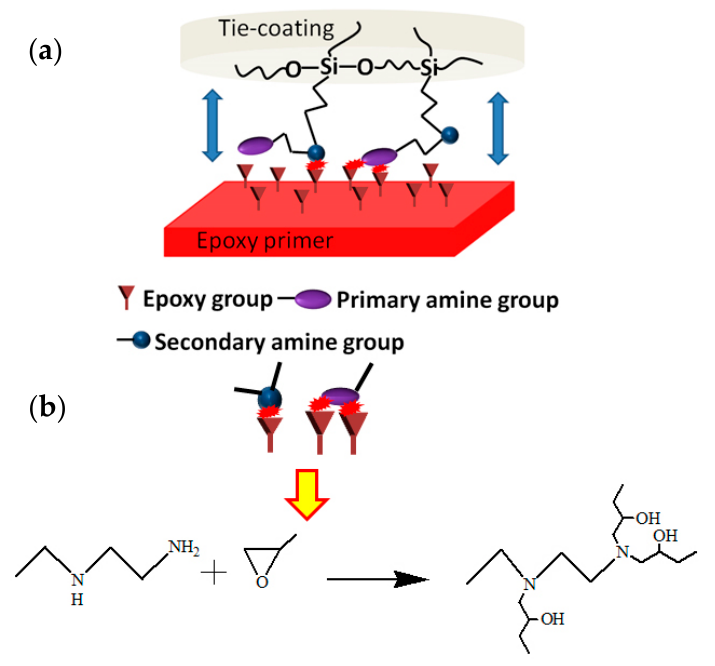
Figure 11. The tie method between epoxy primer and silicone tie-coating: ( a ) Schematic diagram of tie mechanism; ( b ) reaction formula.